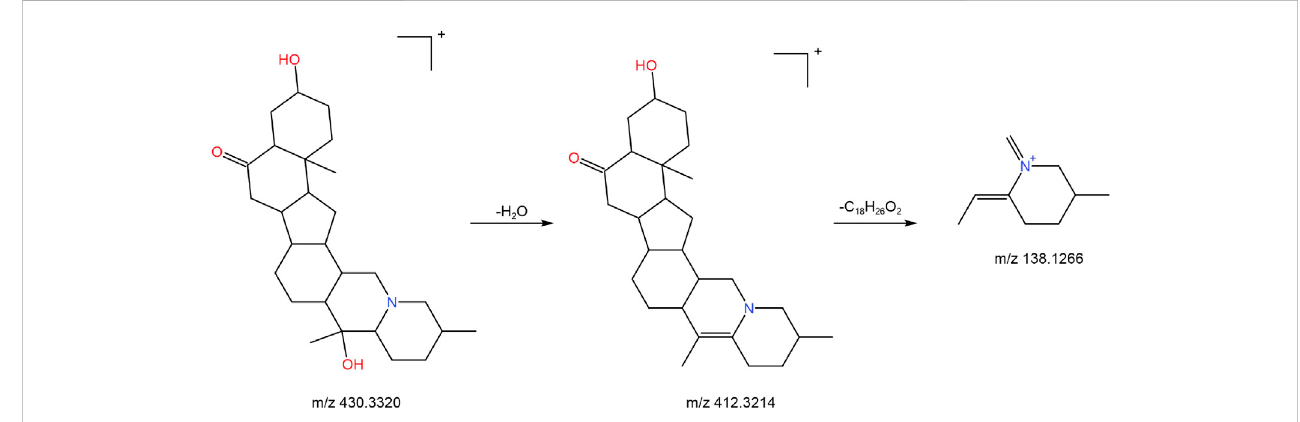
FIGURE 8 The FP of imperialine in positive ion mode.